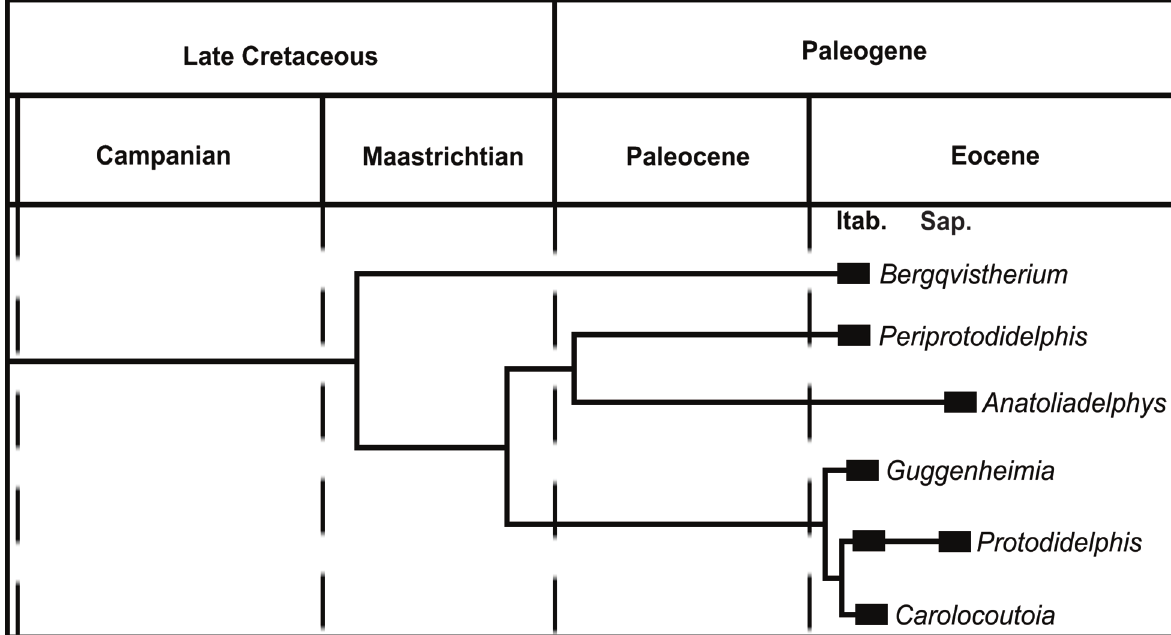
Figure 5 - temporal cladogram of the Protodidelphidae. Phylogeny of the Protodidelphidae calibrated in time, based on the phylogeny present in the figure 4. The wide bars indicate the recorded temporal range of the Protodidelphidae genera. The SALMAs that present protodidelphids are identified. SALMAs : Itaboraian;